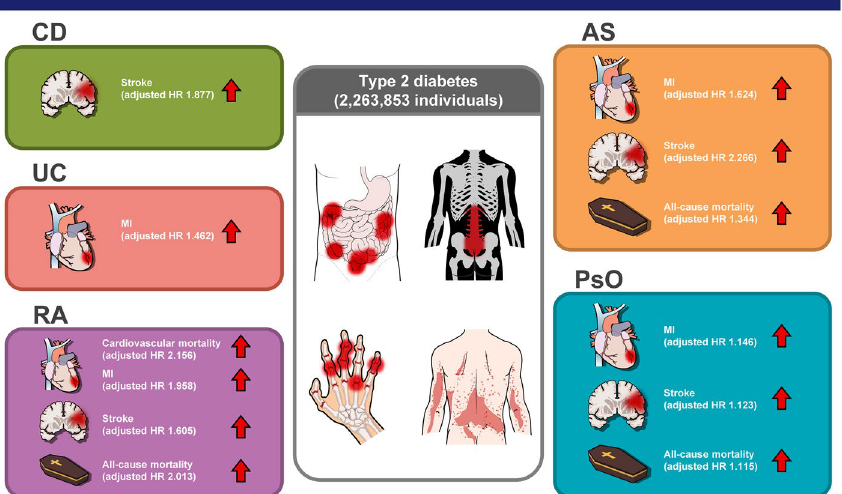
Figure 4. Summary of the present nationwide population-based study. CD, crohn’s disease; UC, ulcerative colitis; RA, rheumatoid arthritis; AS, ankylosing spondylitis; PsO, psoriasis; HR, hazard